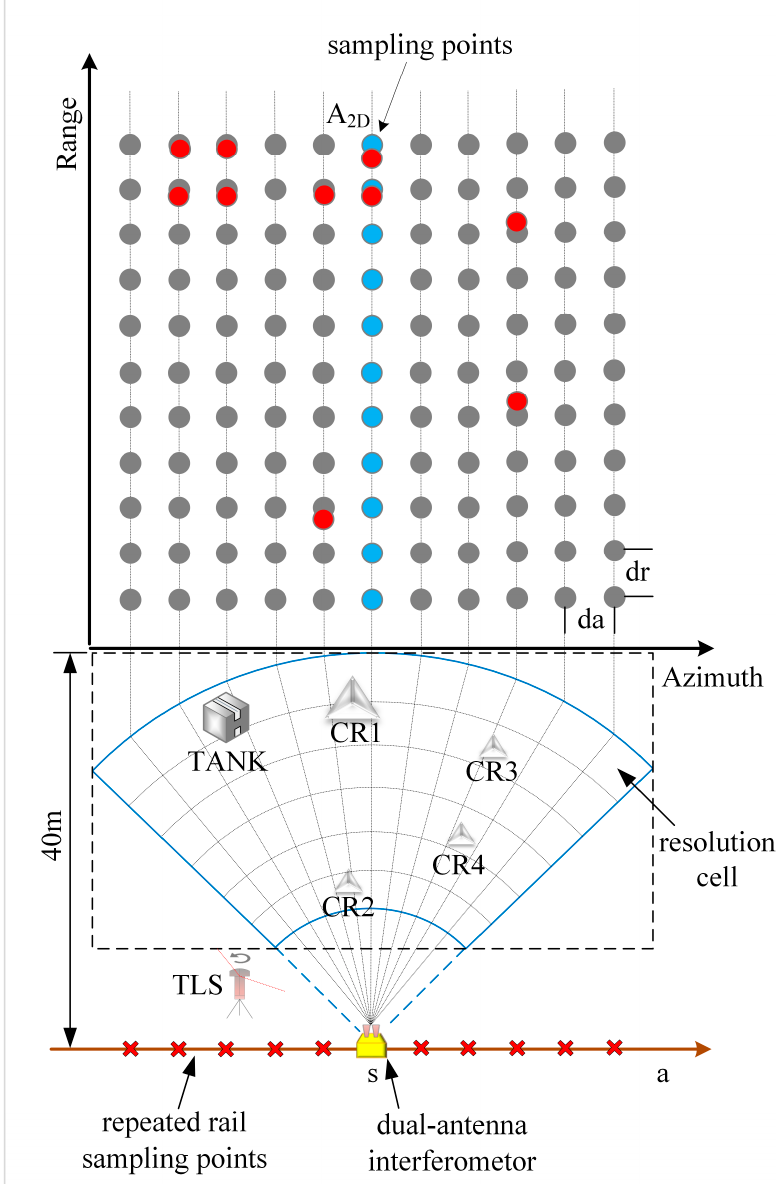
Figure 4. Signal spatial distribution of main targets and GB-SAR image spatial mapping relation.